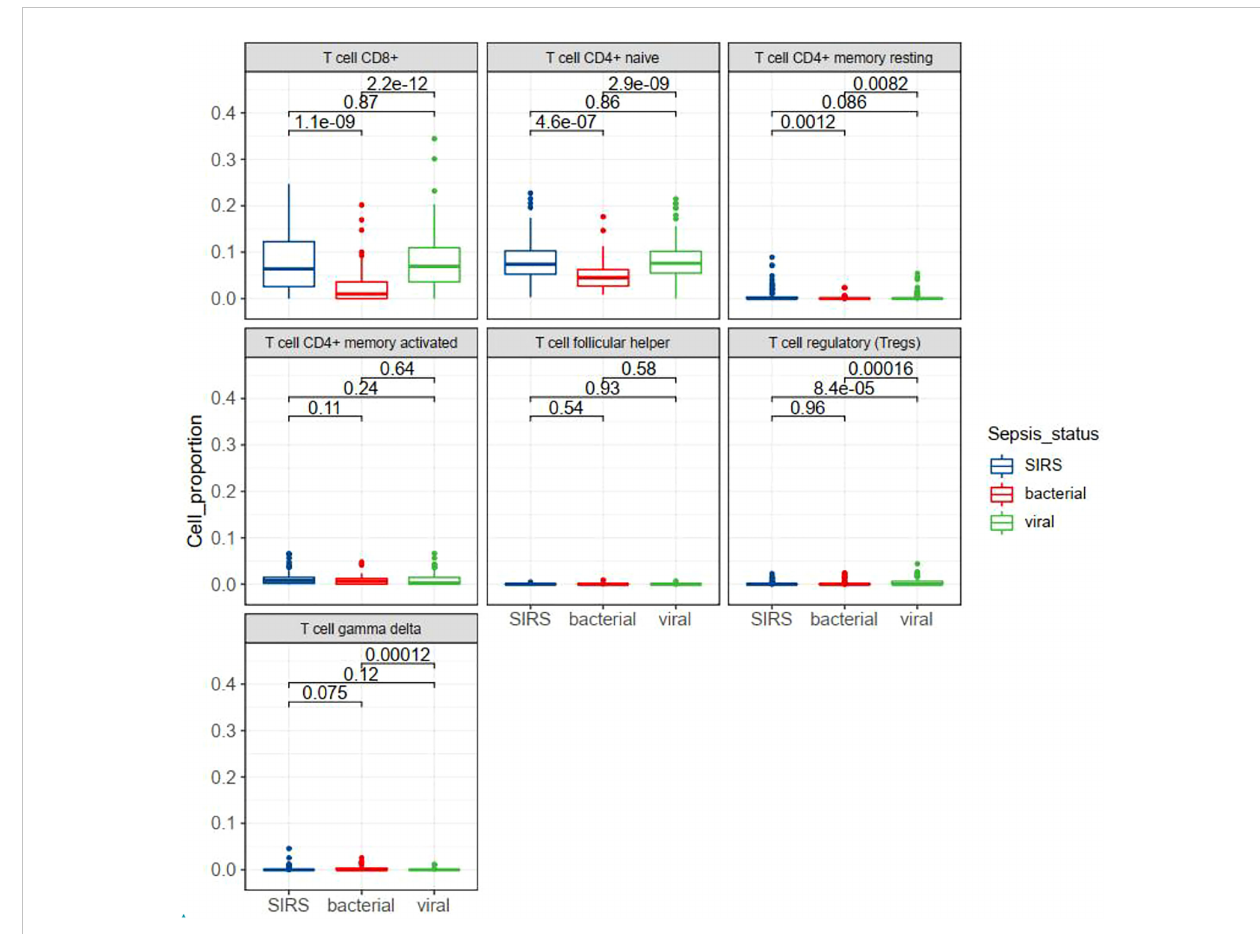
FIGURE 8 Box plots showing the differential expression of seven T cell subsets in different status of sepsis. SIRS, systemic in fl ammatory response